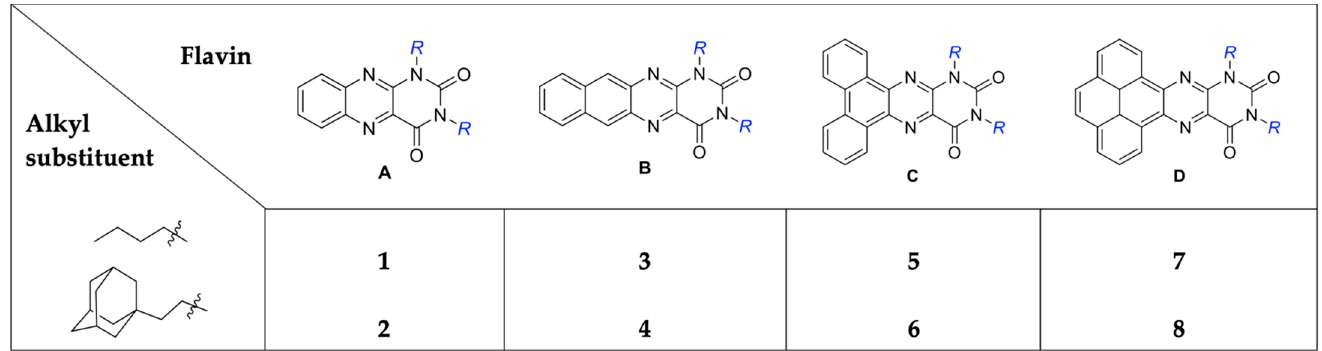
Figure 1. The structures of the compounds under investigation (flavins 1 – 8 ). For the unsubstituted flavins, R = H.